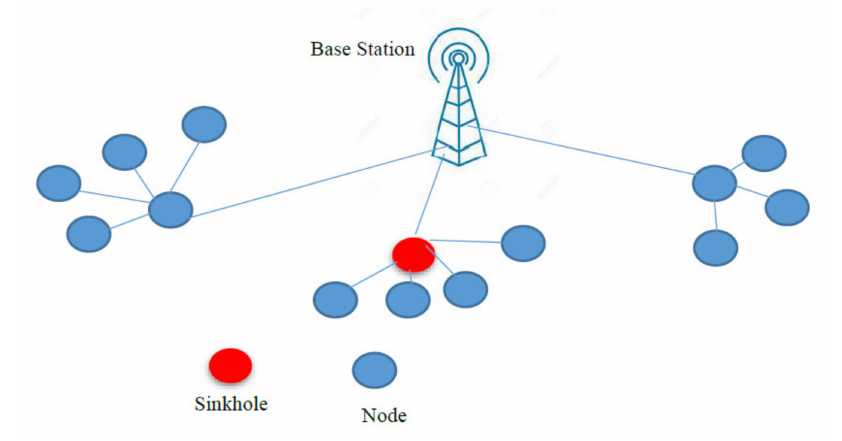
Figure 3. Sinkhole attack